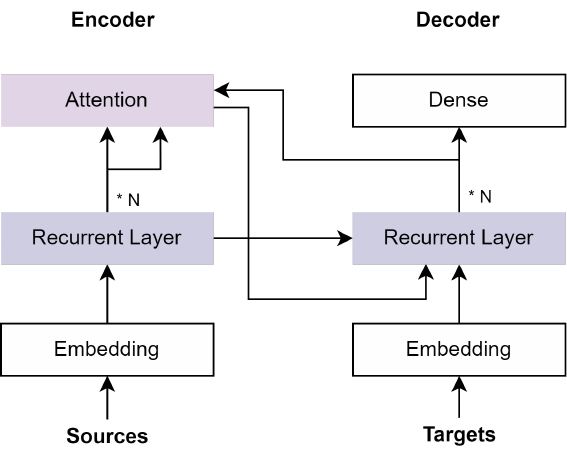
Figure 1. S2S encoder–decoder with attention